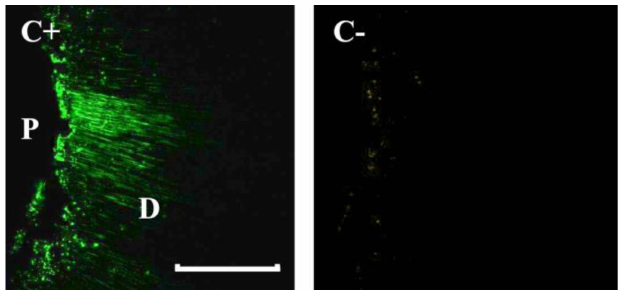
Figure 3. Confocal laser scanning microscopy composite reconstructions of dentinal tubules of positive ( C + ) and negative ( C- ) controls. D , dentin; P , pulpal side. The scale length is 300 µ